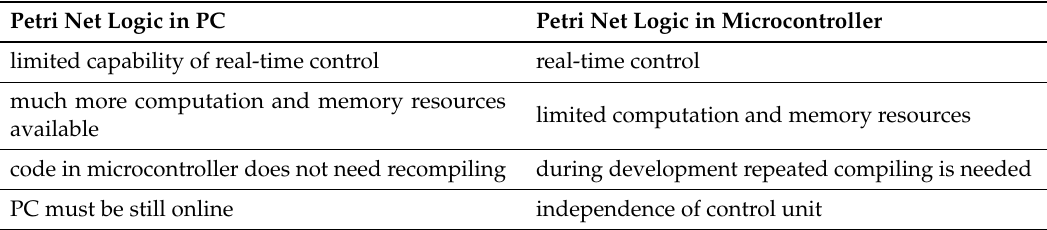
Table 1. Comparison of two concepts of system control using Petri